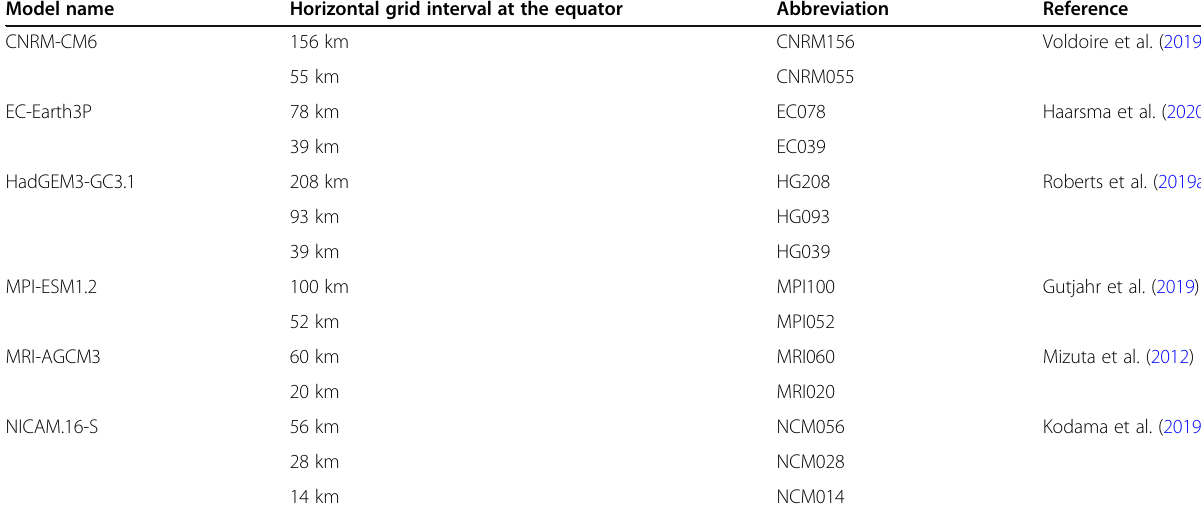
Table 1 Lists of models and horizontal grid intervals used in the present study Model